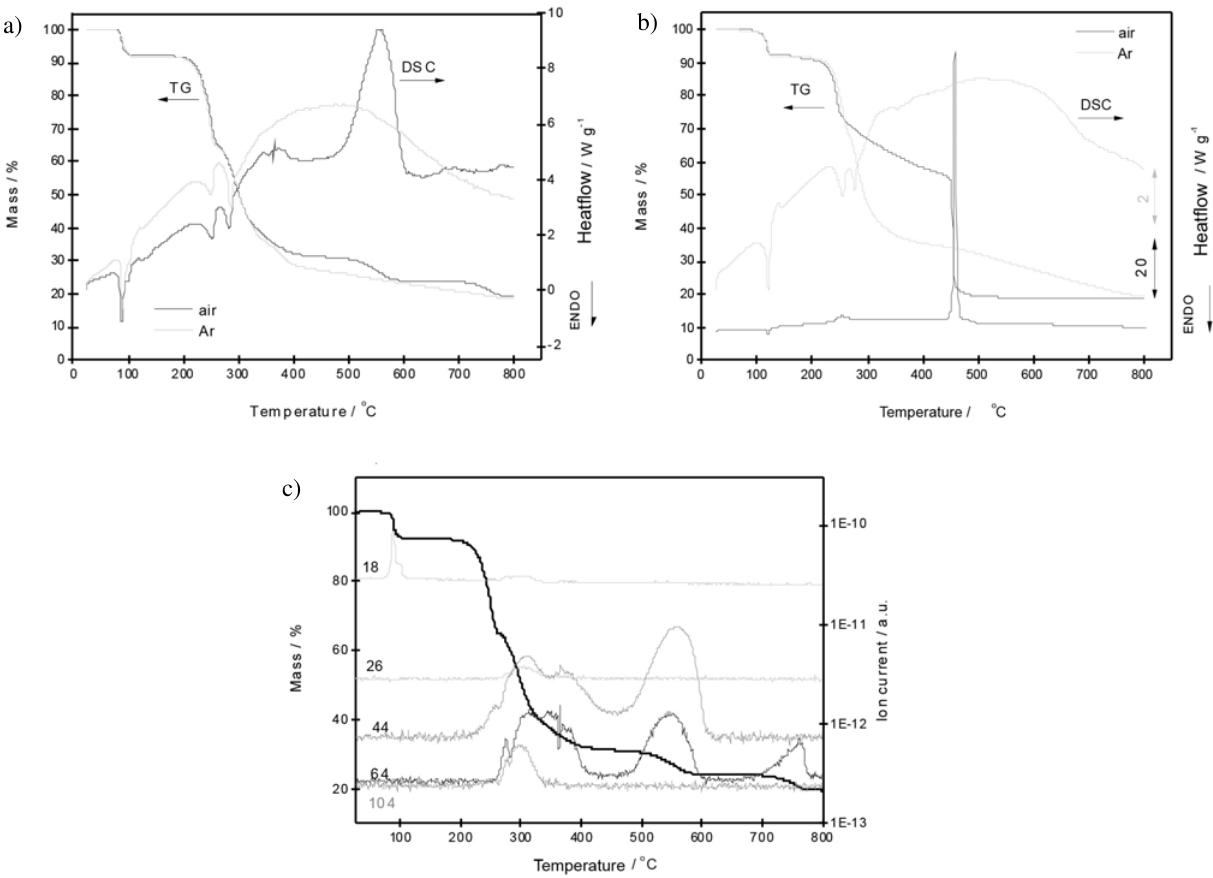
Figure 3. TG and DSC curves of a) Mn complex ( 1 ) and b) Fe-complex ( 2 ), and c) TG-MS curve of Mn complex ( 1 ) under air atmosphere. Note that in Fig. b two different scales on a DSC curve are presented, due to reducing the enthalpy signal under air atmosphere the first and the second DSC signals are not clearly